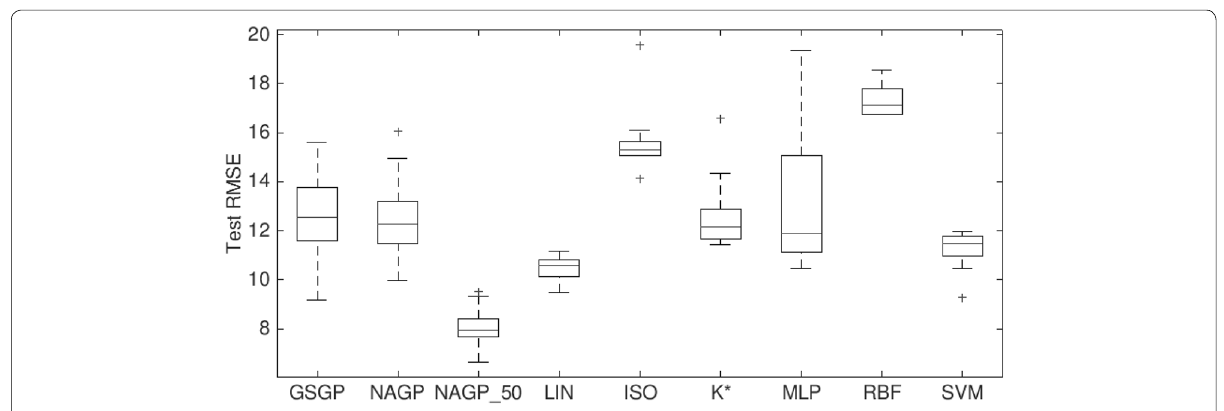
Fig. 10 Root mean squared error on the test set.